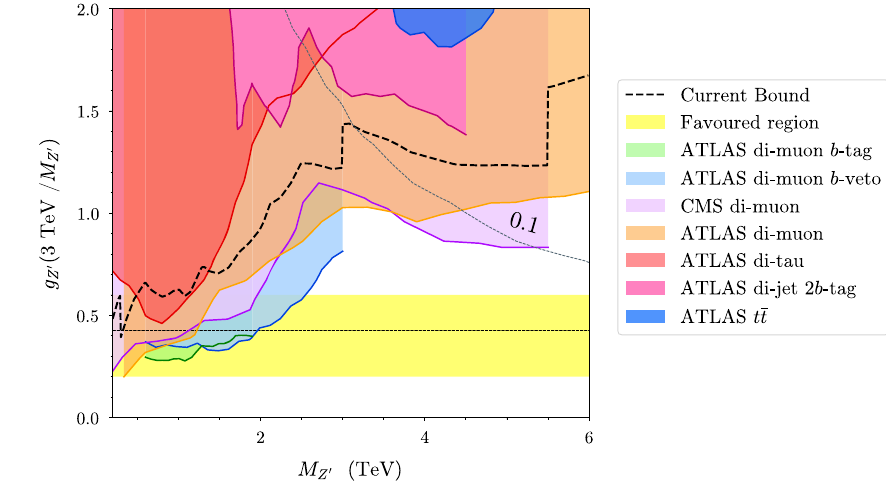
Fig. 17 Summary of our estimate of the 95% CL sensitivity regions of HL-LHC Z (cid:2) searches in the TFHM. The yellow band indicates the region favoured by the flavour and electro-weak data at the 95% CL, and the horizontal dashed black line indicates the line of best fit. The region above the dashed grey line has (cid:10)/ M > 0 . 1. Toward the Z (cid:2) extreme left-hand side of the plot, our predictions become more inaccurate due to / M 2 ) unaccounted-for O ( M 2 Z Z (cid:2) relative